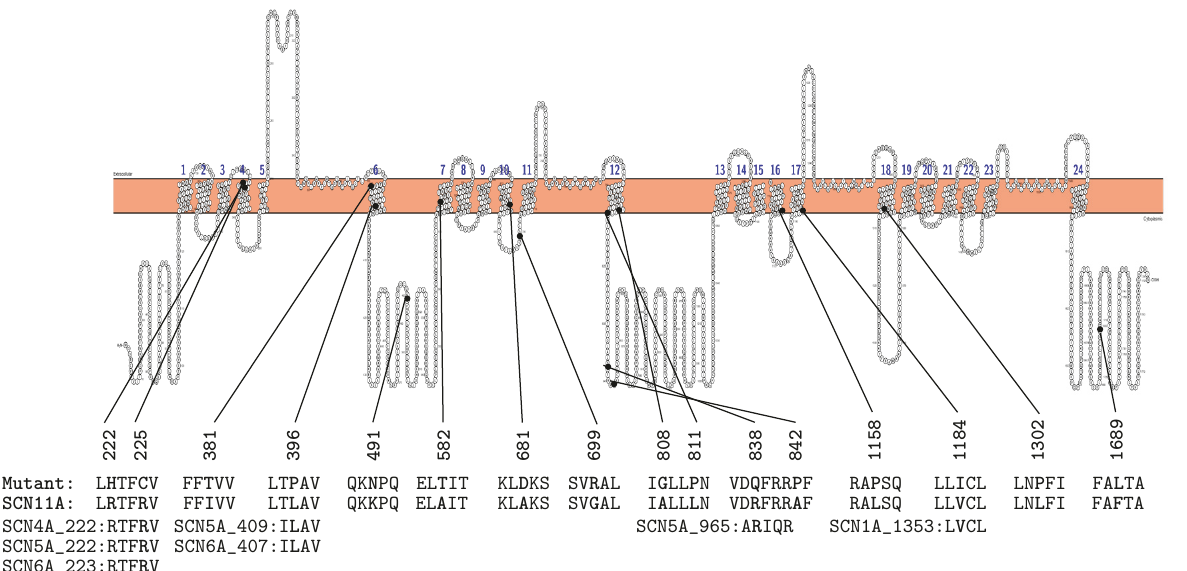
Figure 1: Locations and paralogue analysis of SCN11A variants associated with pain diseases in the Nav1.9 channel. The Nav1.9 channel, like other sodium channels, is composed of 24 transmembrane segments organized into four domains. Mutated residues are in bold, black dots represent locations of mutated residues in the channel. Amino acid residue number is given above mutated residue. Paralogue sodium channels along with mutated residues and their numbers are given below equivalent residues in